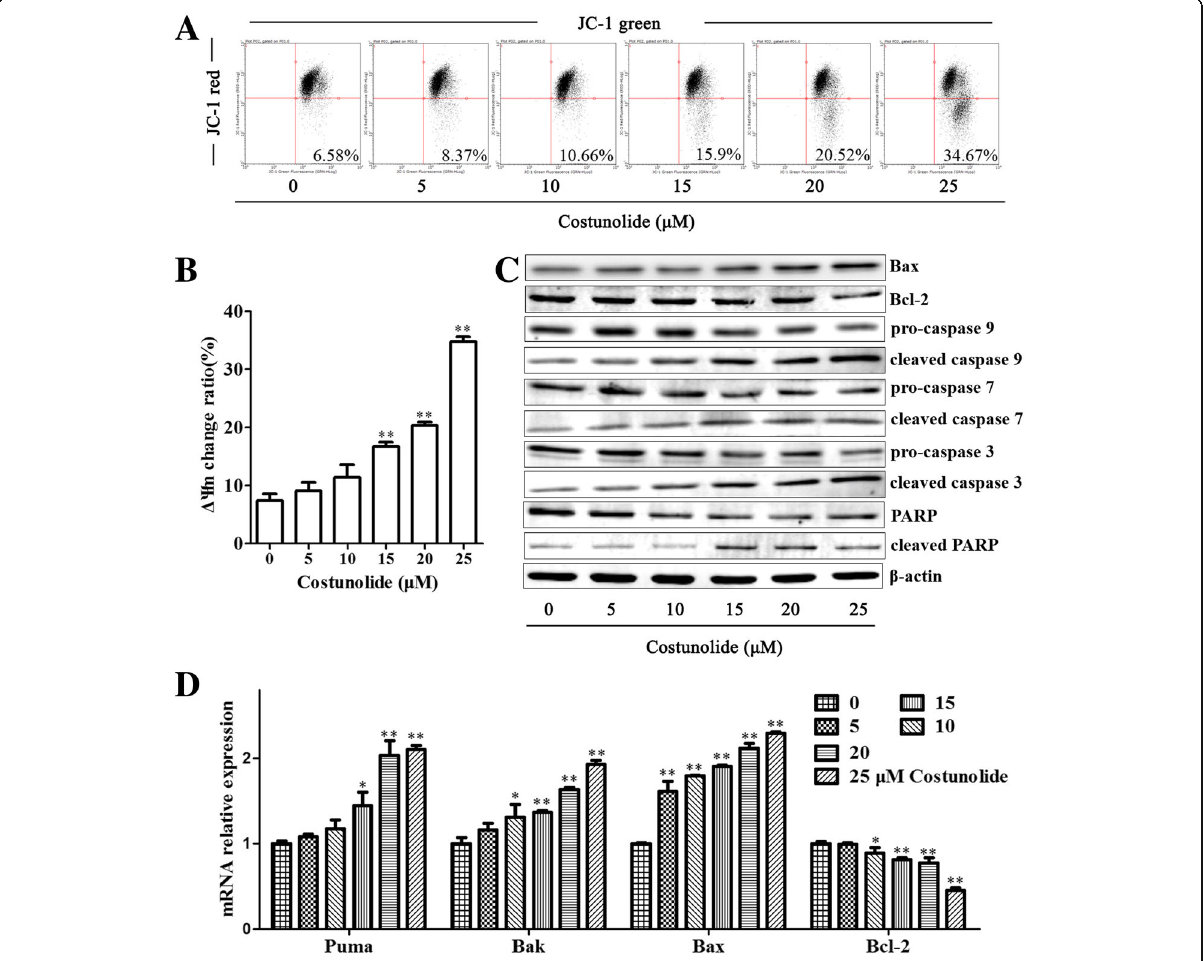
Fig. 3 Costunolide changed the ΔΨ m and induced mitochondria-mediated apoptosis in gastric adenocarcinoma cells. a ΔΨ m of BGC-823 cells treated by costunolide with different concentration (0, 5, 10, 15, 20 and 25 μ M) for 24 h and stained by JC-1 is detected by flow cytometry. b Statistical data of ΔΨ m change ratio. c Apoptosis related proteins (Bax, Bcl-2, pro-caspase 9, cleaved caspase 9, pro-caspase 7, cleaved caspase 7, pro-caspase 3, cleaved caspase 3, PARP and cleaved PARP, β -actin is internal reference protein) of BGC-823 cells treated by costunolide with different concentration (0, 5, 10, 15, 20 and 25 μ M) for 24 h is detected by WB. d Apoptosis related genes (puma, Bak1, Bax and Bcl-2, GAPDH is internal reference gene) expression of BGC-823 cells treated by costunolide with different concentration (0, 5, 10, 15, 20 and 25 μ M) for 24 h is detected by Q-PCR. Compared to control group, * P < 0.05, ** P <